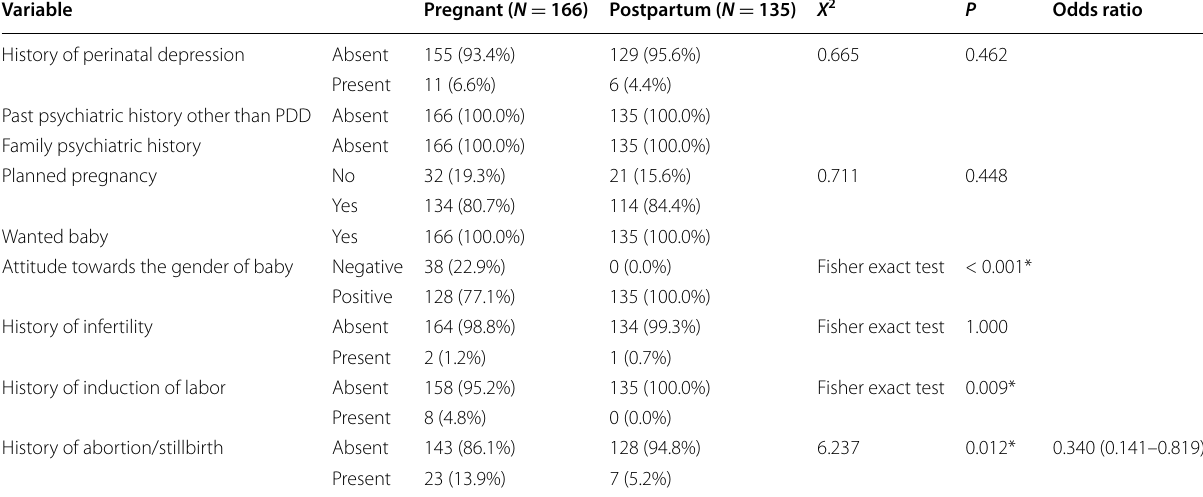
X 2 , chi-square test. *Statistically